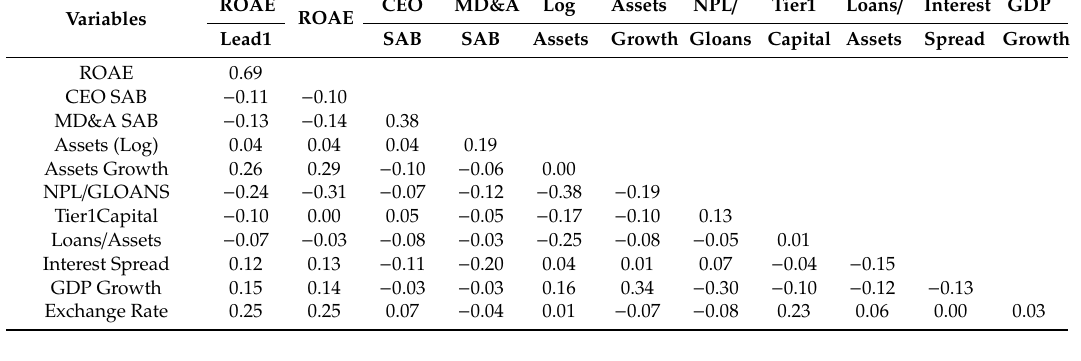
Table 3. Correlation Matrix of SAB, Financial and Macro-Economic variables.